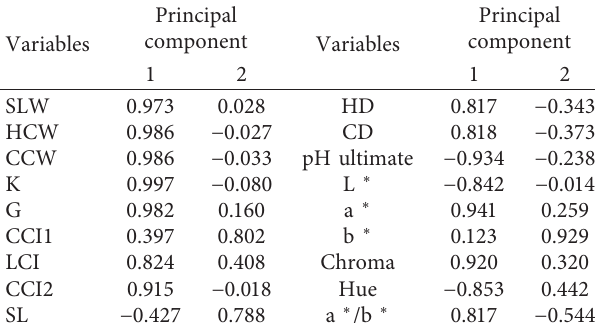
Table 4: Two main components explaining more than 83% of the total information on the carcass and meat quality traits of Beni-Guil and Ouled-Djellal sheep